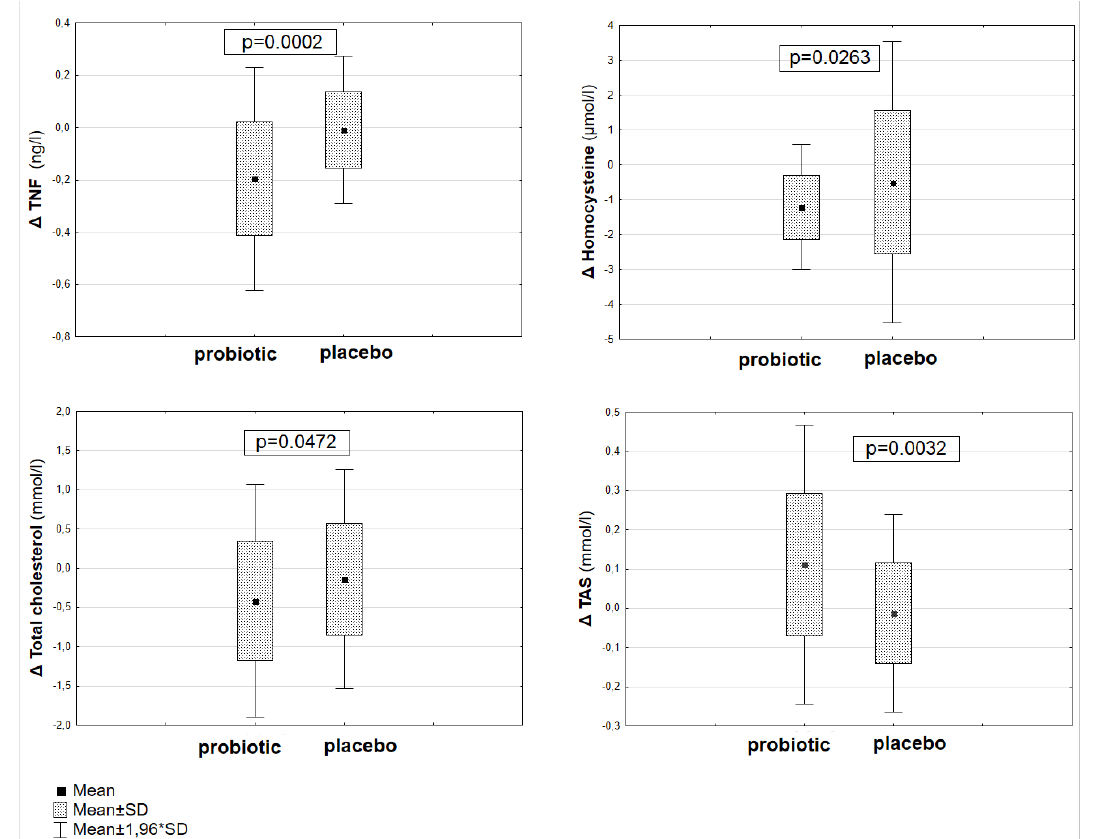
Figure 1. Comparative analysis of the change ( ∆ ) in Hcy, tumor necrosis factor α (TNF- α ), total cholesterol (TC) and total antioxidant status (TAS) concentration between